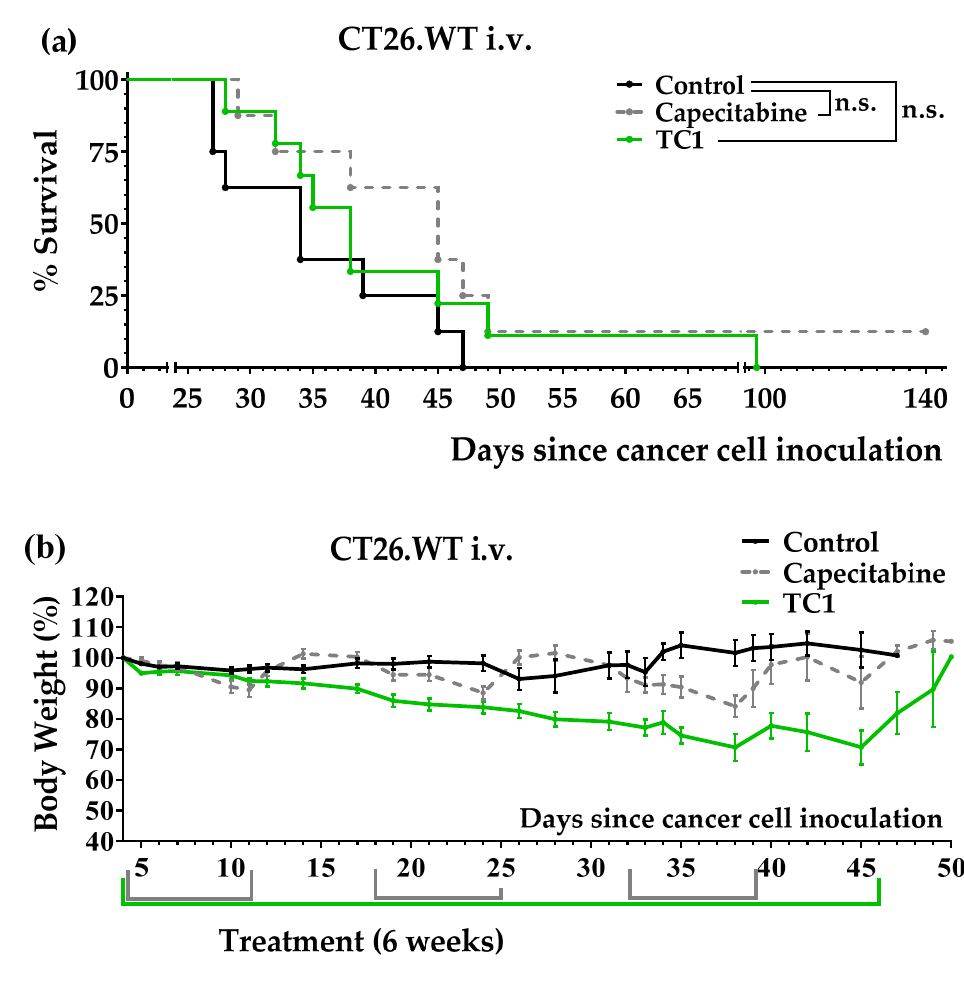
Figure 4. Anticancer activity of diet TC1 and capecitabine in mice with colon cancer (lung metastasis model; CT26.WT murine colon cancer cells inoculated in the tail vein of immunocompetent BALB/c mice). ( a ) Survival of the mice with colon cancer left untreated (control), treated with diet TC1 (6 weeks), or treated with capecitabine (450 mg/kg/day, 7/7 schedule, 3 cycles). ( b ) Body weights (mean percentage ± SEM) relative to the body weights at the beginning of treatments (day 4). The p -values were calculated with the GBW test. n.s. means no